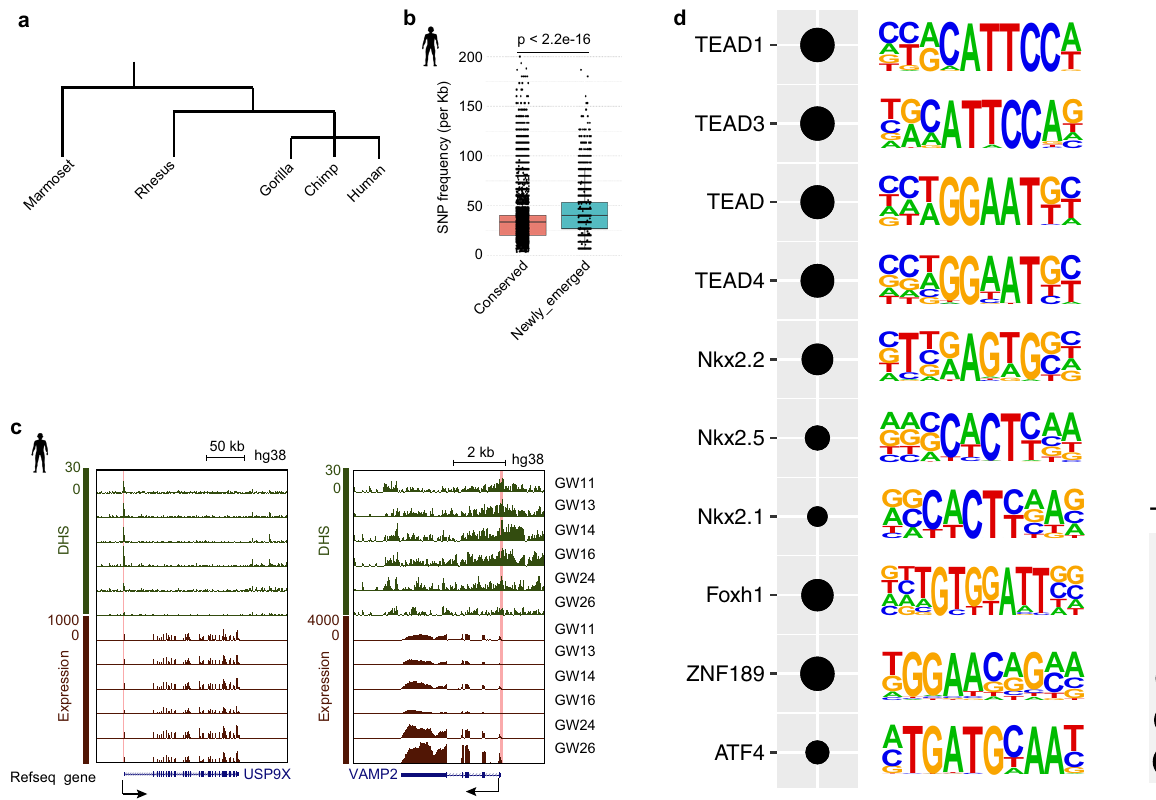
Fig. 4 Identi fi cation of human newly emerged regulatory elements. a The evolutionary tree of primates. b Box and jitter plots comparing SNP frequencies (SNP numbers per kb) between newly emerged DHSs ( n = 3831) and conserved DHSs ( n = 212,304) in the human population. Boxes and whiskers represent the 25th/75th percentiles and 1.5 ´ the interquartile range, respectively. The center in the boxplot represents the medium value. Student ’ s t test with a two-sided model was used. c Genome browser view showing promoter DHS and expression of USP9X and VAMP2 during human PFC development. The pink shadow marks the newly emerged DHSs. d Enriched transcription factor binding motifs in newly emerged human DHSs. P values are calculated based on the hypergeometric